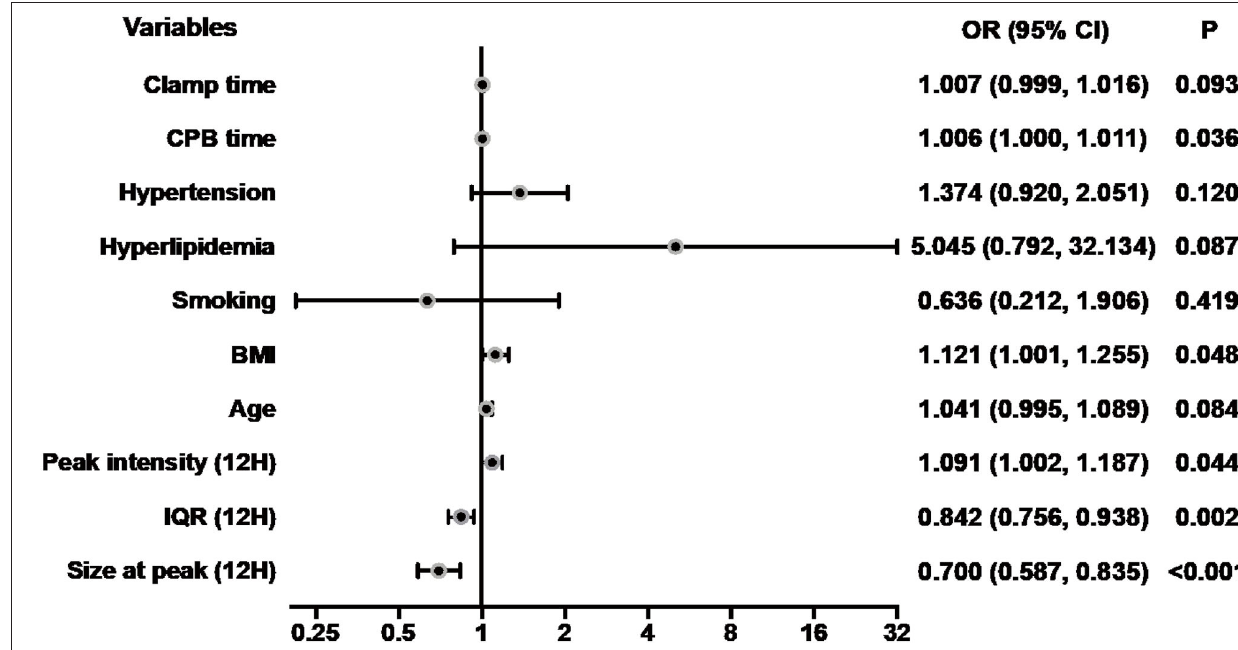
FIGURE 6 | Forest plot for logistic regression analysis. The odds ratios for acute lung injury according to size at peak (12H) and selected risk factors. CPB, cardiopulmonary bypass; BMI, body mass index; IQR, interquartile range; Size at peak (12H), the size at peak at 12h after operation; OR, odds ratios; CI, confidence